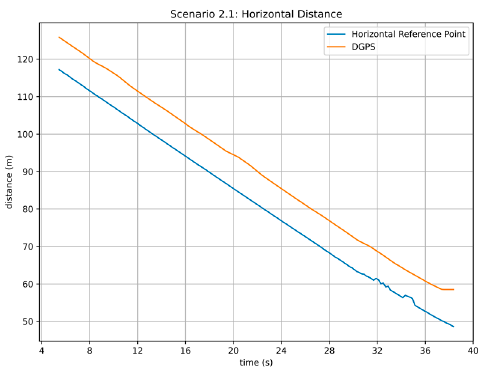
Figure 17. Scenario 2.1 horizontal distance to quay wall.